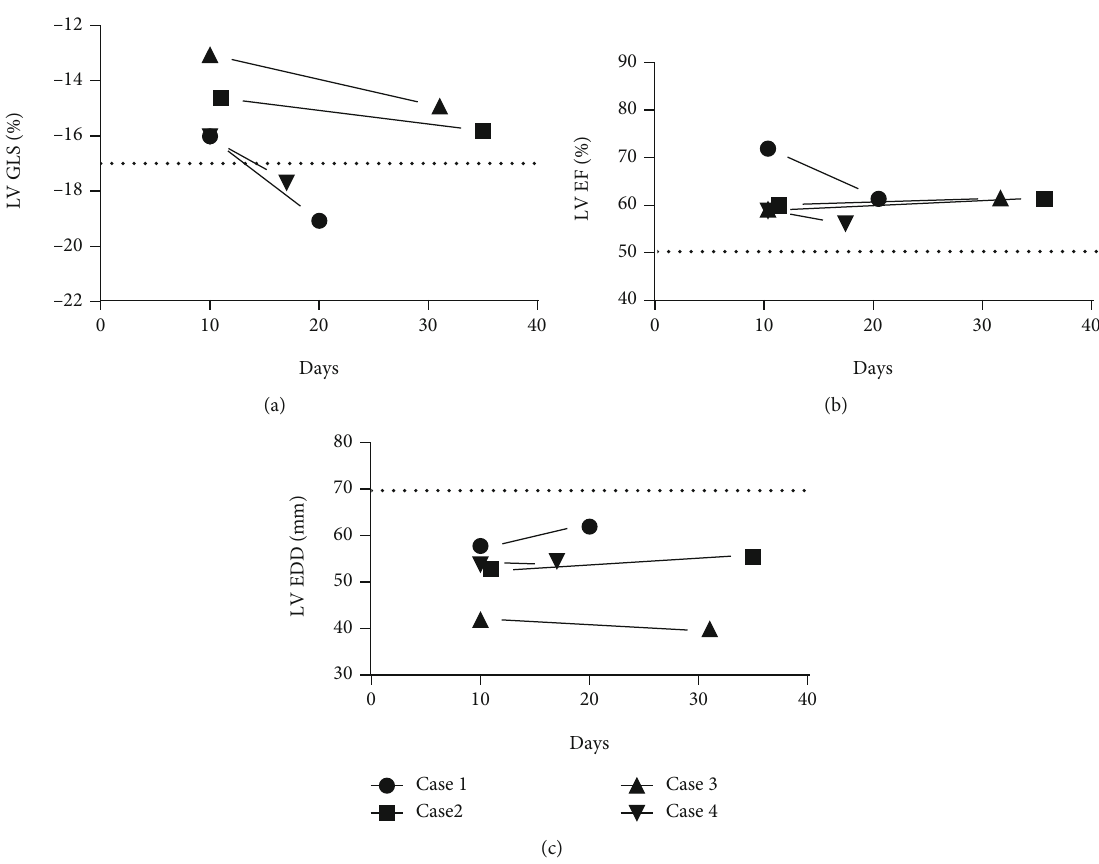
Figure 1: Transthoracic echocardiography fi ndings following COVID-19 diagnosis. (a) LV GLS at ~ 10 days postinfection is abnormal in all cases [1]. (b) LVEF was normal in all cases. (c) LV dilation (LVEDD) [1] did not occur following